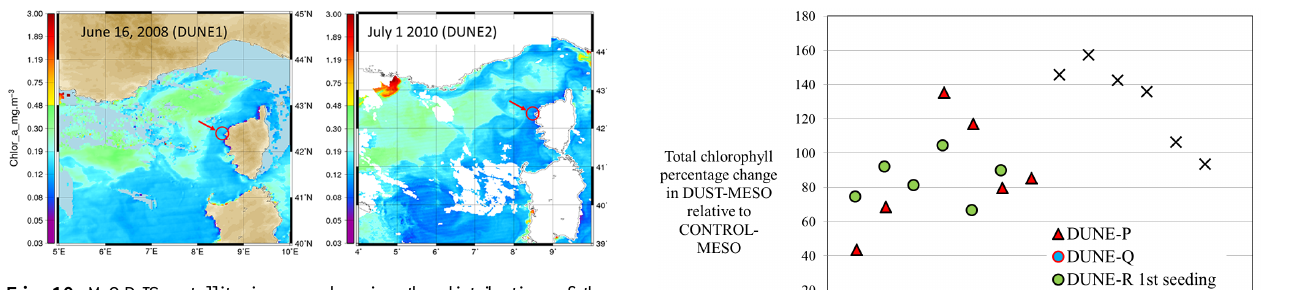
Fig. 10. MODIS satellite images showing the distribution of the surface chlorophyll a at the time of DUNE-1 (left) and DUNE-2 (right). The red circle and arrow indicate the position of the experi- ment.